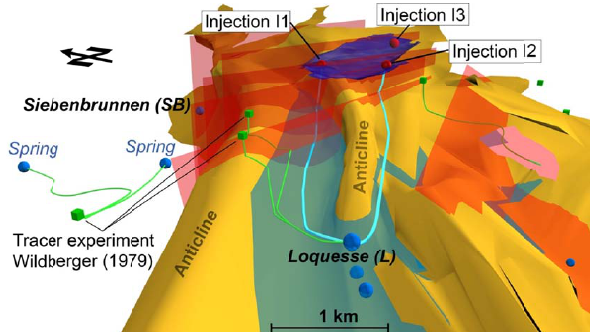
Figure 3 : Visualizatio Fig. 3. Visualization of possible meltwater flow paths through the Morte. R Red and trans karst below Glacier de la Plaine Morte. Red and transparent planes represen nted in green, visible in n the middle ( are faults. Tracing experiments carried out by Wildberger in 1979 transpar rency are kar are represented in green, including the expected underground flow the glacie paths. The Glacier de la Plaine Morte is visible in the middle (dark blue). Blue spheres are karstic springs. The blue surfaces with some transparency are karstic nappes. The two flow paths (light blue) coming from tracer injection points on the glacier are inferred from the available